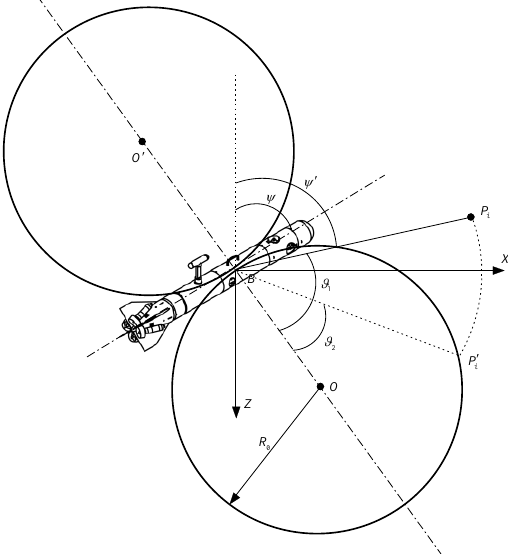
Figure 16. Relative position of ZFAUV and the waypoint.